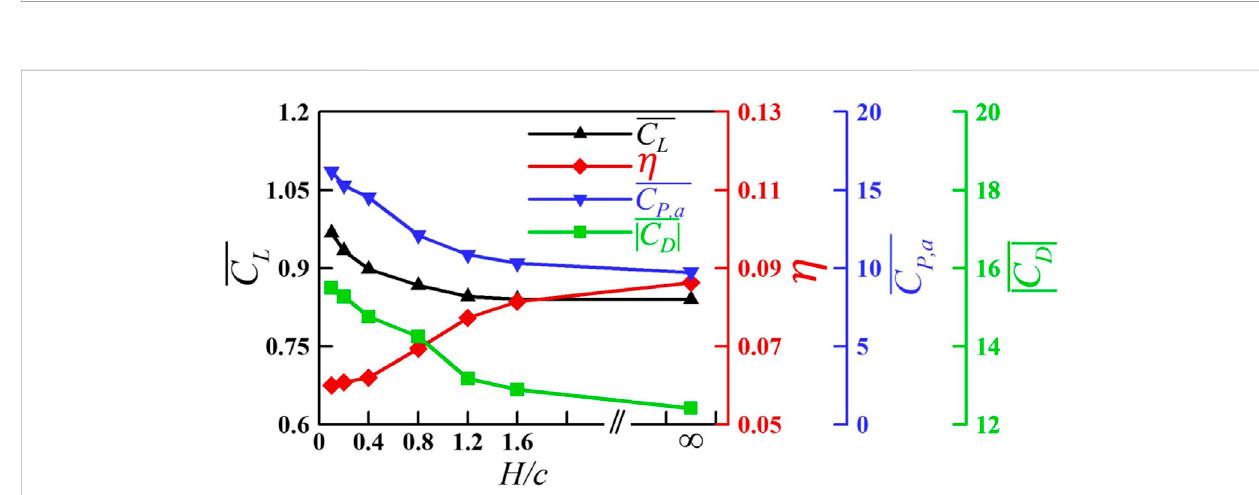
FIGURE 15 Variation in C L , C P , a , η , and the mean absolute value of the drag | C D | of the wing as a function of wing – wing separations ( H ). The symbol “ ∞ ” indicates the single wing